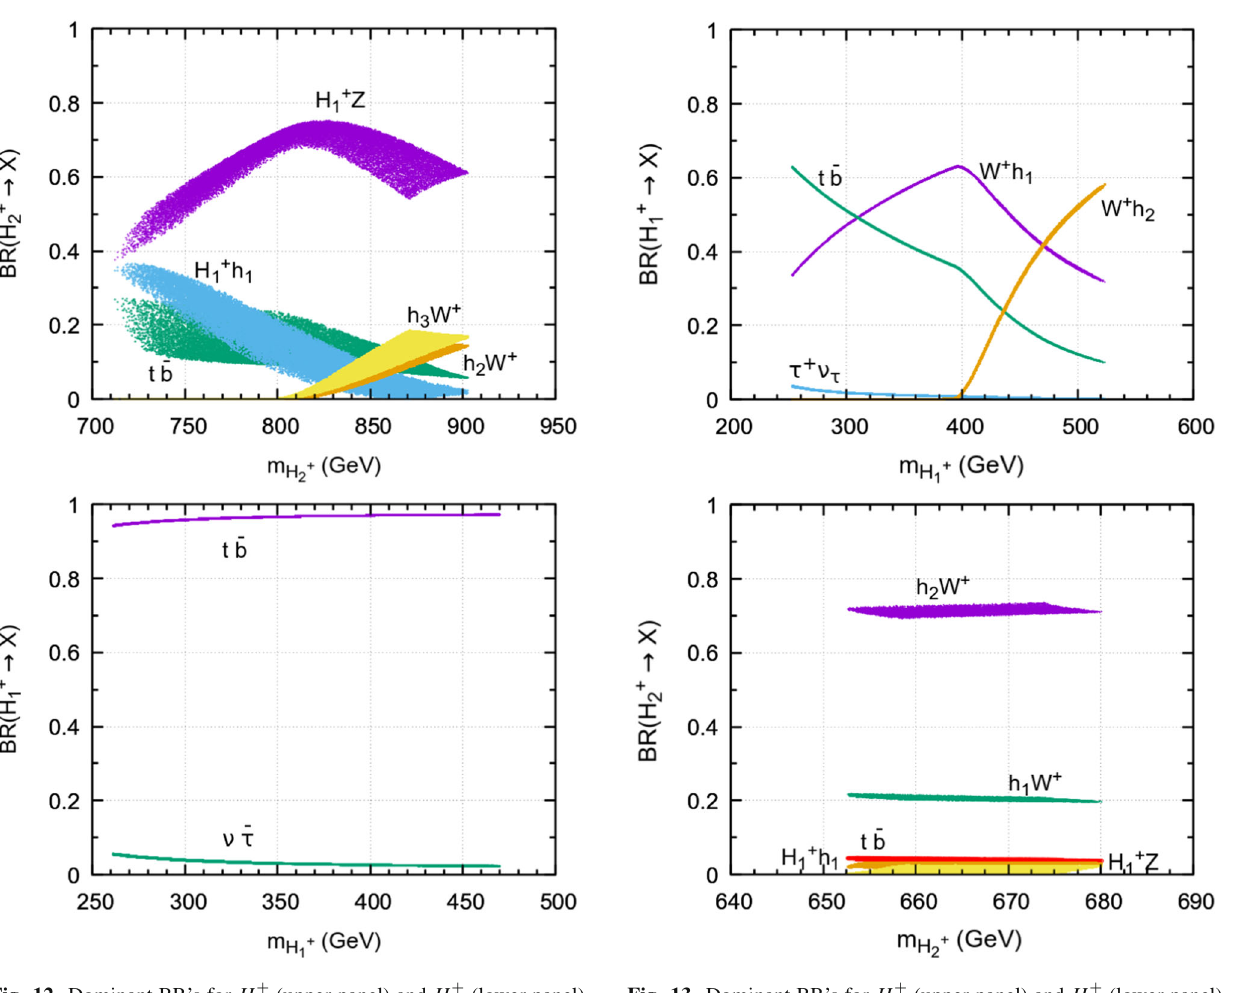
(upper panel) and H + (lower panel) 1 2